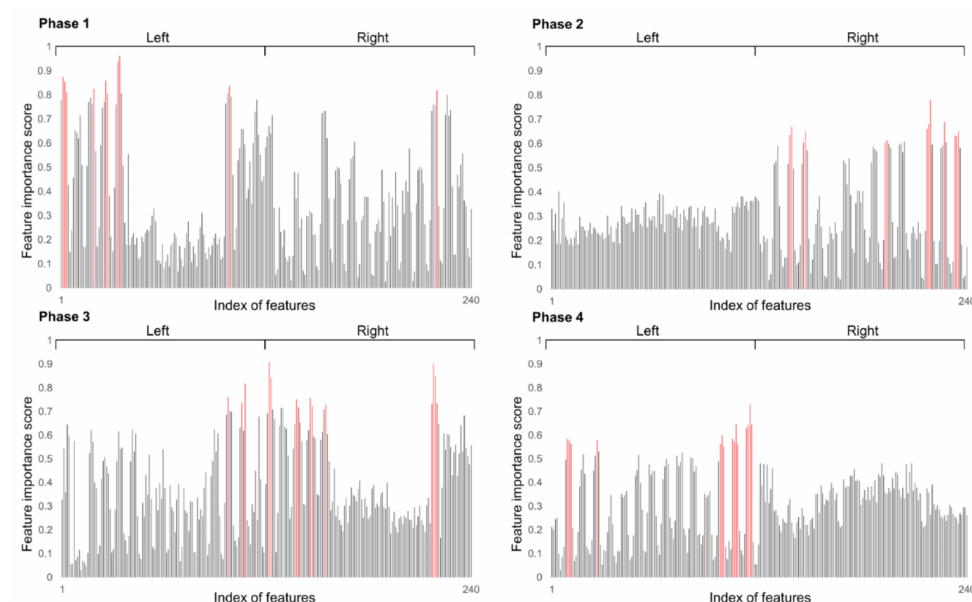
Figure 12. Feature selection result. Selected features from 240 candidates are colored red.